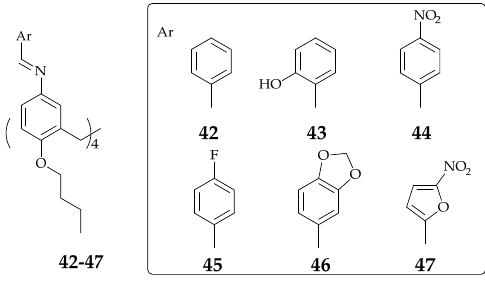
Figure 7. Structures of iminecalix[4]arene derivatives 42 – 47 .